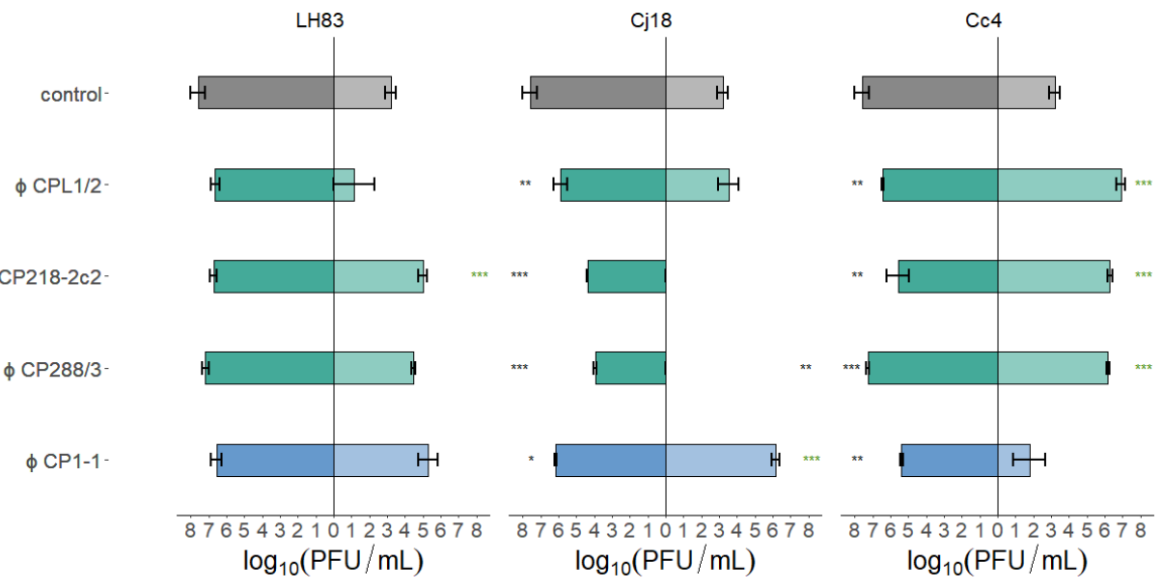
Figure 5. Final phage concentrations after single-phage planktonic killing assays with three different Campylobater field isolates. C. jejuni LH83, Cj18, and C. coli Cc4 were exposed to either one of the three group II phages (CPL1/2, CP218-2c2, and CP288/3) or the group III phage (CP1-1) at MOI input 10 ( ■ / ■ / ■ ) or MOI input 0.001 ( ■ / ■ / ■ ). Experiments were performed in triplicate or quadruplicate. Dun- nett’s test with a 95% confidence level was used to compare the phage concentrations at the begin- ning of the experiments with those after 24 h (significance code indicates range of p values: * 0.01, ** 0.001, *** >0.001; * final concentration higher than starting concentration). Error bars indicate the standard error of the mean. Control bars represent mean starting concentrations ( ■ / ■ ).